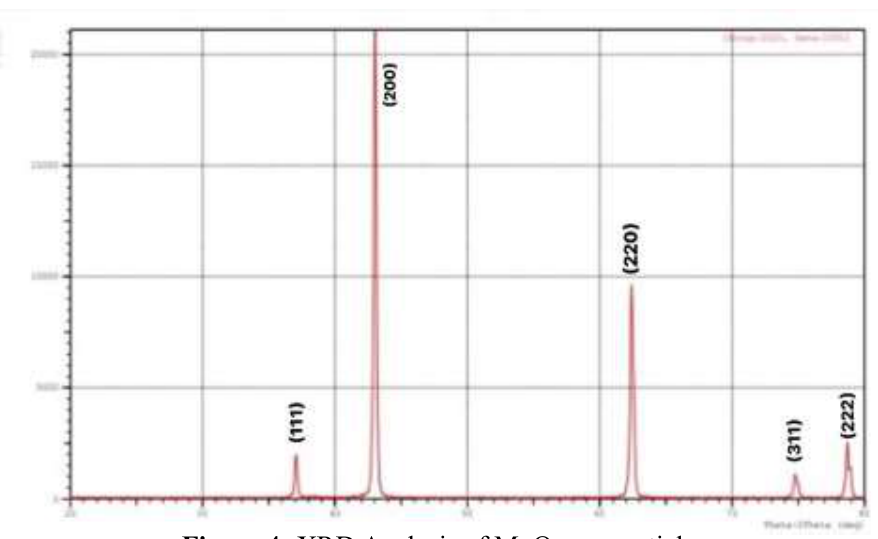
Figure 4: XRD Analysis of MgO nanoparticles